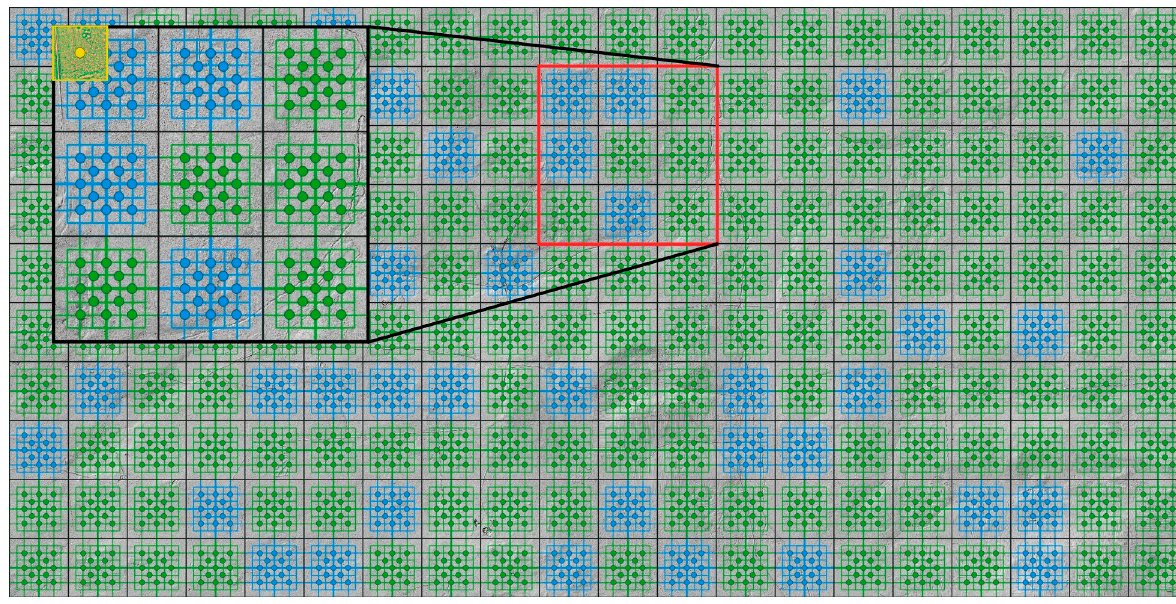
Figure 3. Manually drawn ground truth mask of the training area.